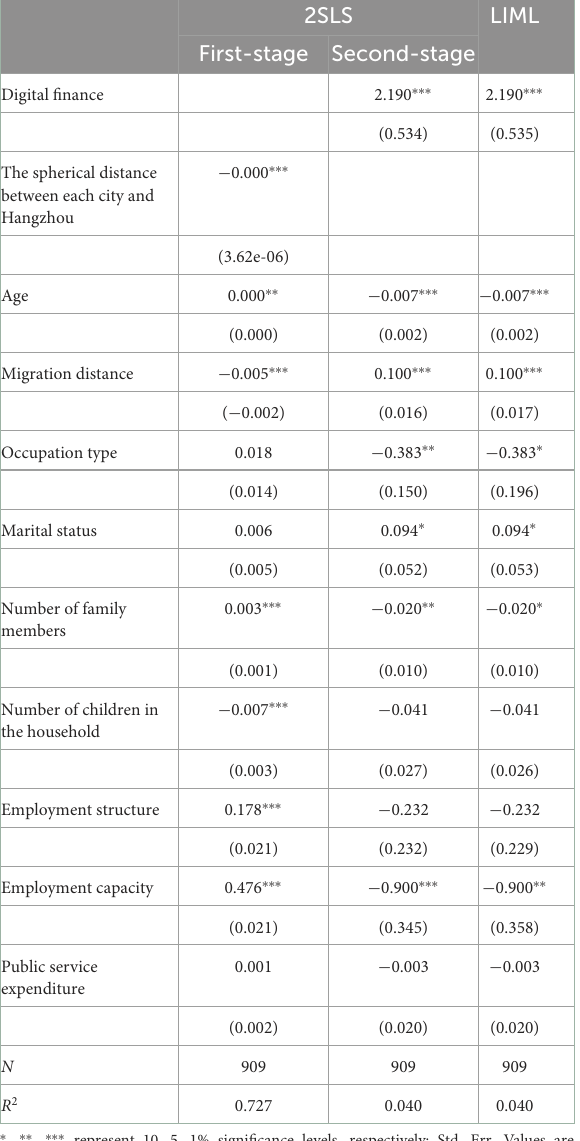
TABLE 4 The regression results of the endogenous